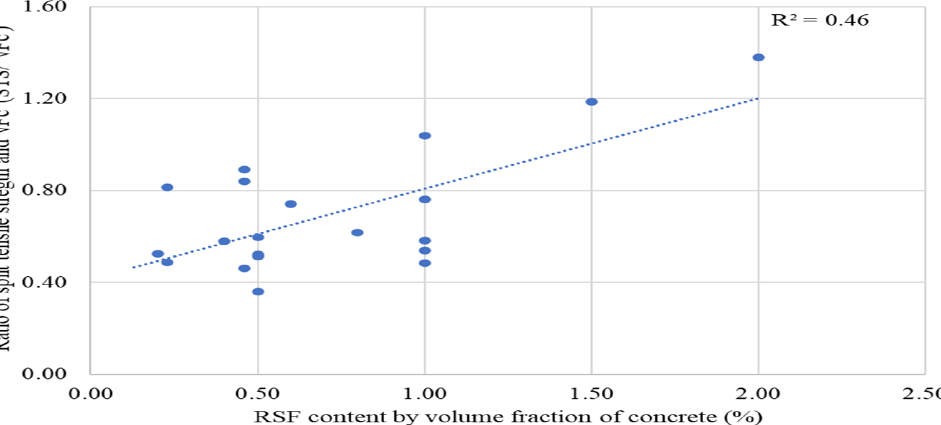
Figure 19. Effect of RSF (0% to 2% by volume fraction of concrete) on the ratio between compressive strength and split tensile strength.